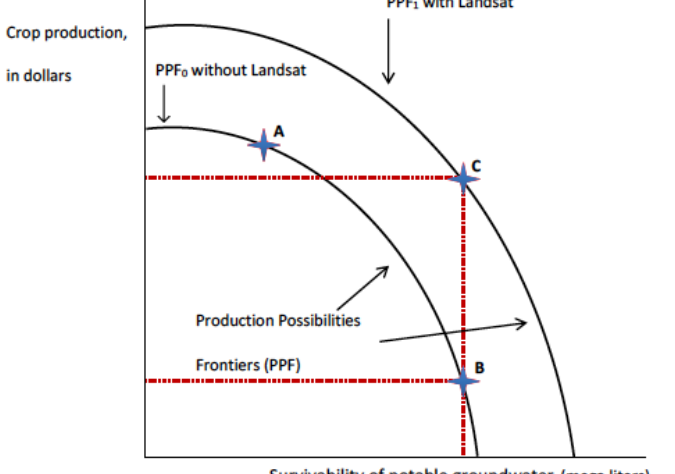
Figure 1. A production possibility curve for a technological innovation in geospatial data (source: